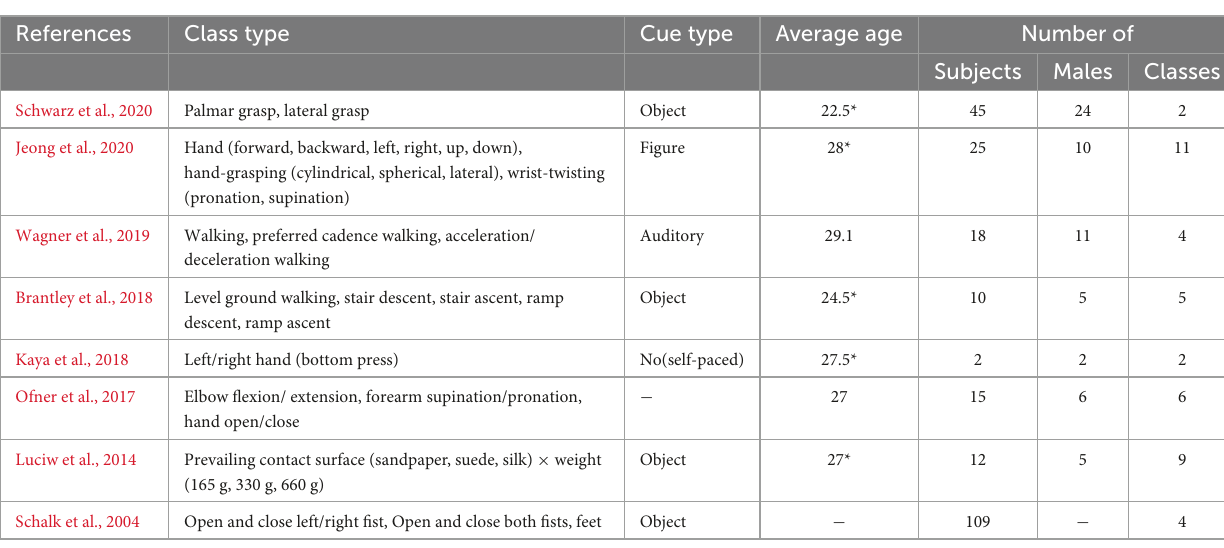
TABLE 3 Paradigm specifications of motor execution datasets (–: no information